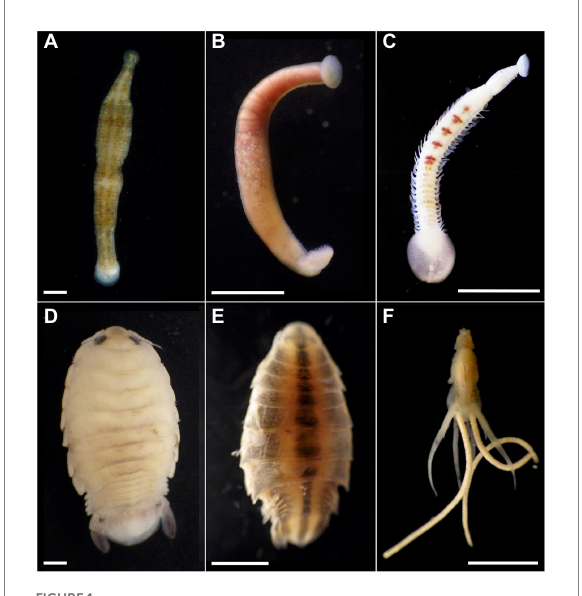
FIGURE 1 Marine blood-feeding invertebrates examined in this study. The bony fish leeches (A) Pterobdella occidentalis and (B) Ostreobdella californiana . Scale bars 1 mm. (C) The elasmobranch leech Branchellion lobata. Scale bar 5 mm. (D) The isopods Elthusa vulgaris and (E) Nerocila californica . Scale bars 2 mm. (F) The copepod Lernanthropus latis . Scale bar 4 mm. Photo credits: S.